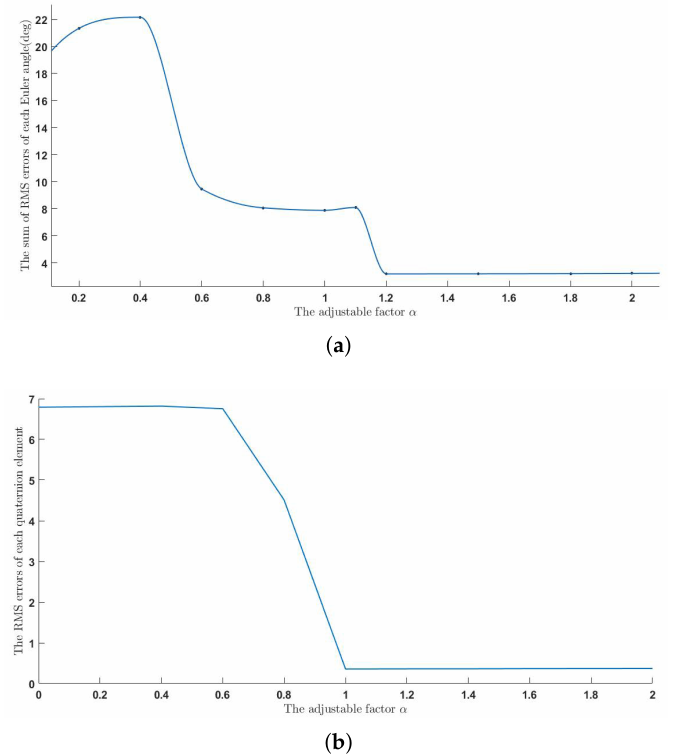
Figure 8. The effect of adjustable factor α . ( a ) The effect of adjustable factor α in dynamic movements. ( b ) The effect of adjustable factor α in random